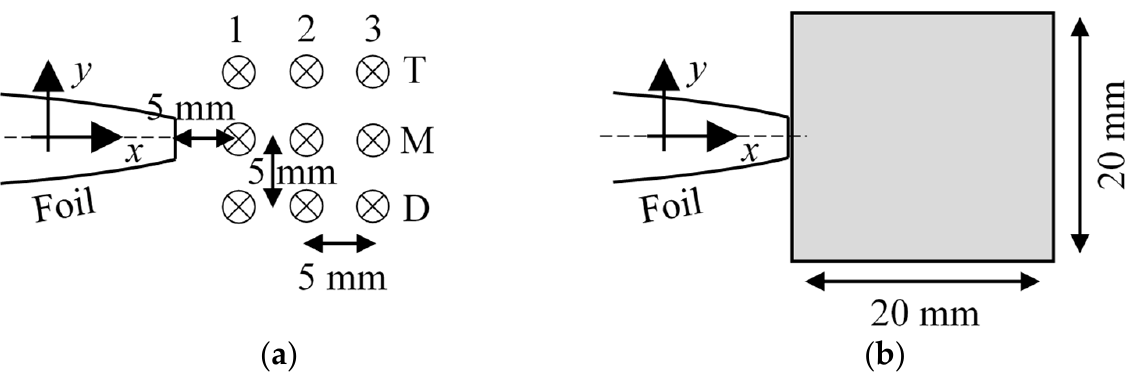
Figure 9. Monitoring points for pressure pulsation analysis. ( a ) Discrete monitoring points for traditional pressure pulsation analysis. ( b ) PTN monitoring for a specific region.